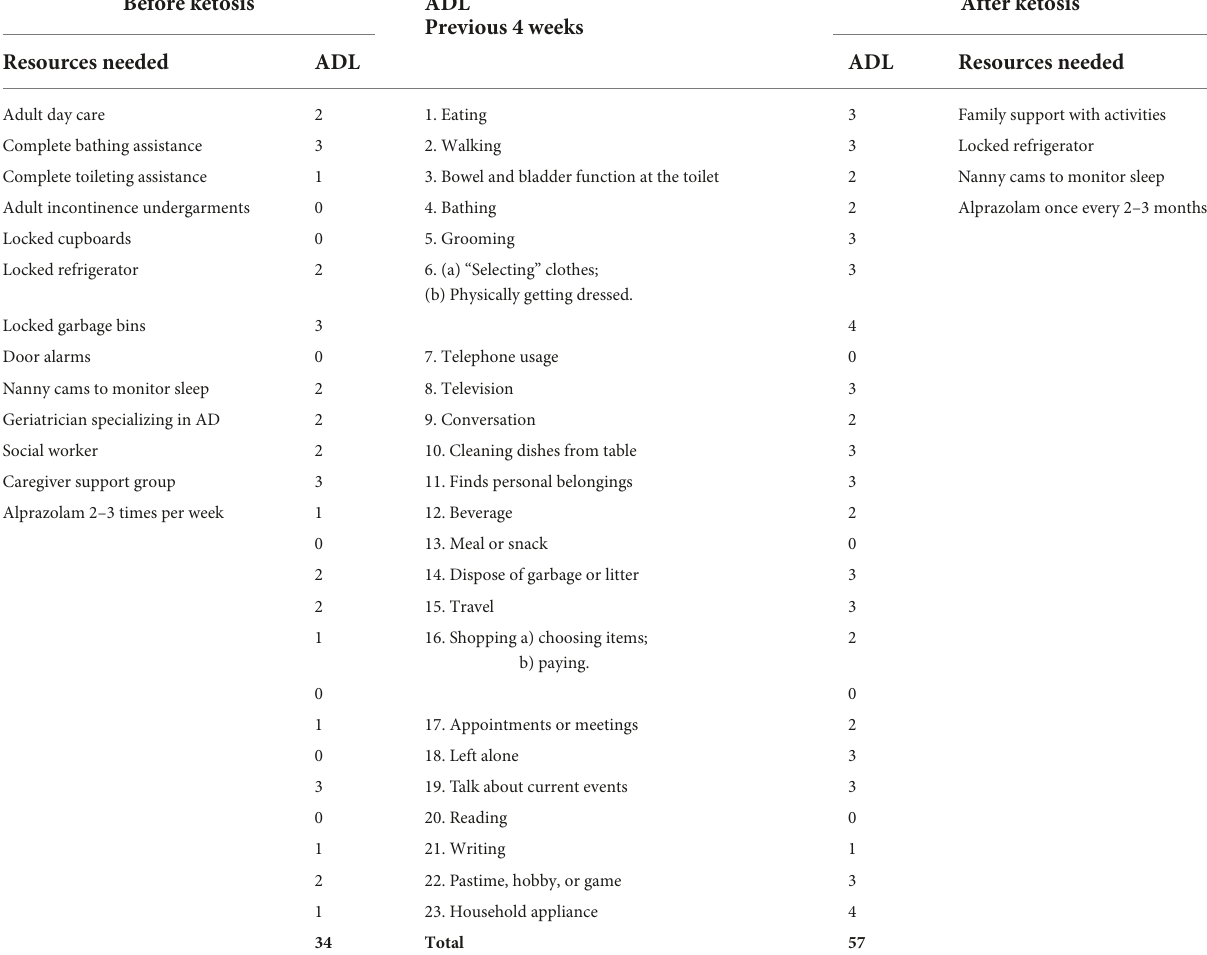
TABLE 1 ADCS–Activities of Daily Living Inventory and resources needed to care for Mary. Before ketosis ADL Previous 4